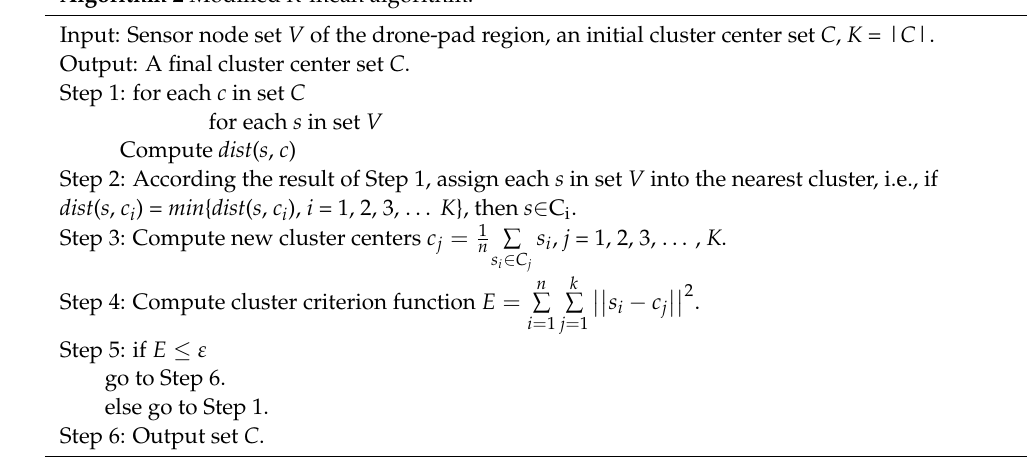
Algorithm 2 Modified K -mean